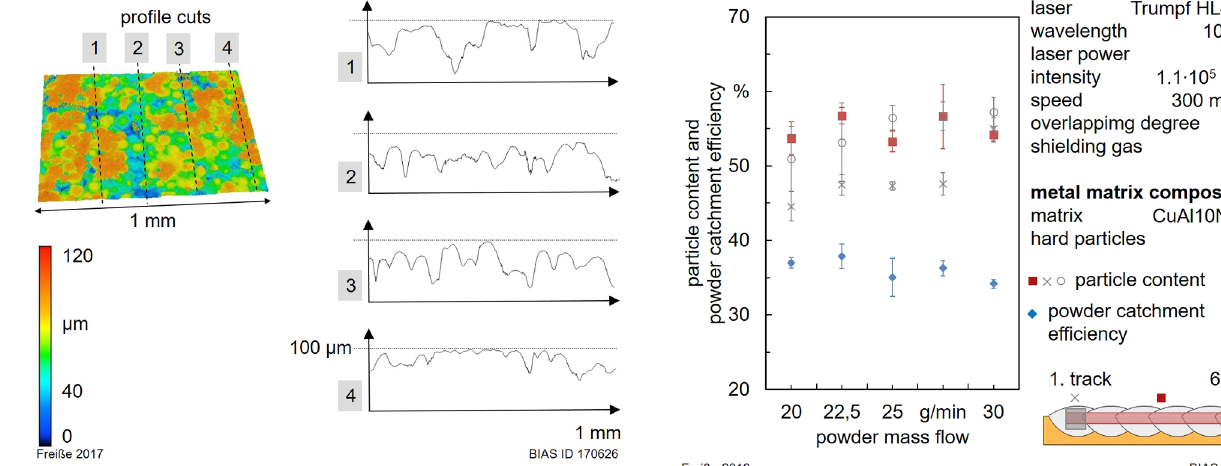
Fig. 6. Variation of powder mass fl ow in laser melt-injected multitracks showing a constant particle content and a decrease of powder catchment ef fi ciency.